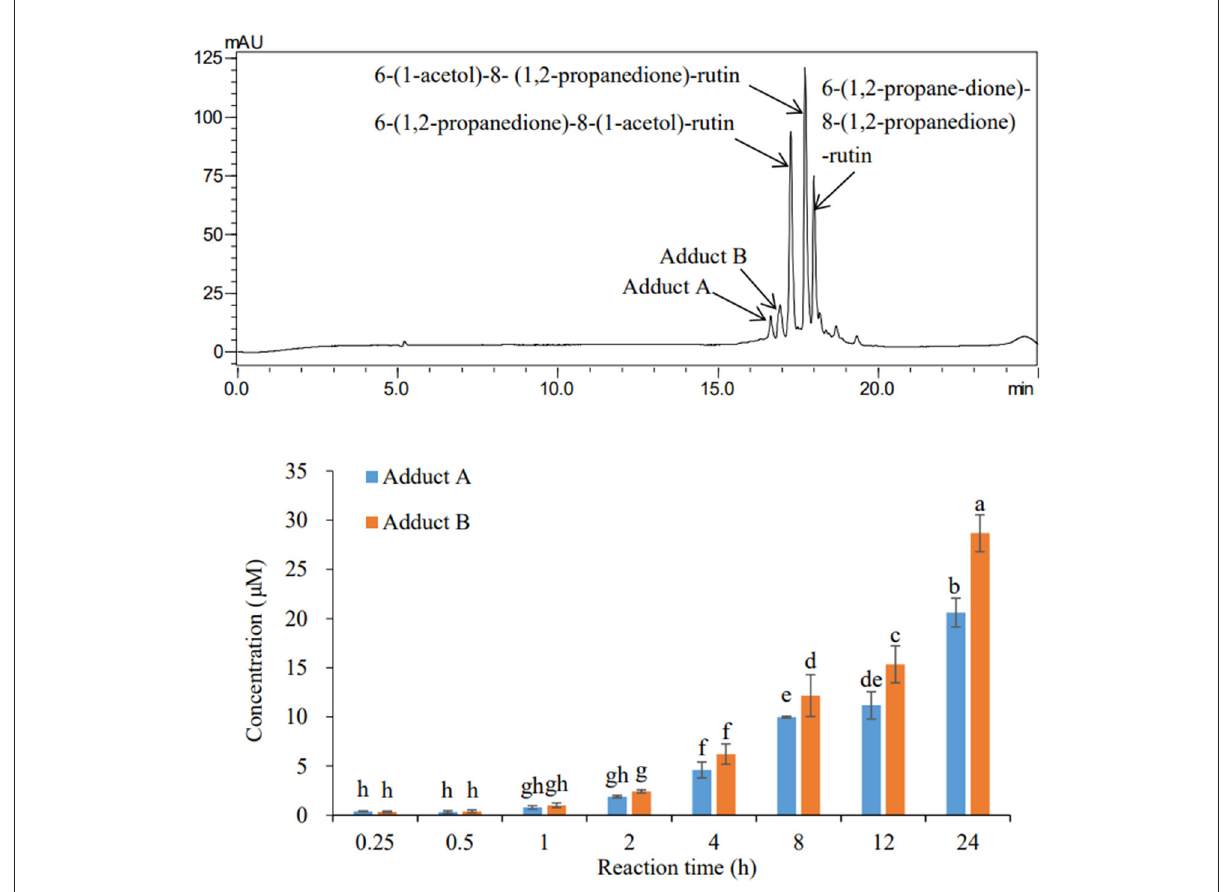
FIGURE1 HPLC chromatogram (upper) of the adducts and their formation levels (bottom) during 24 h incubation of rutin and MGO under simulated physiological condition.